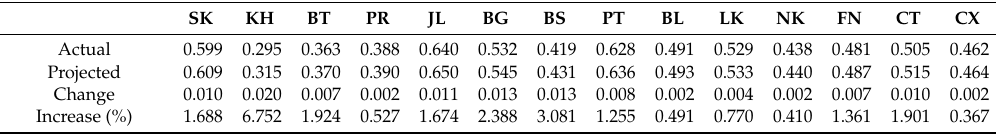
Table 16. Poverty rate in sea level rise regions in Bangladesh.